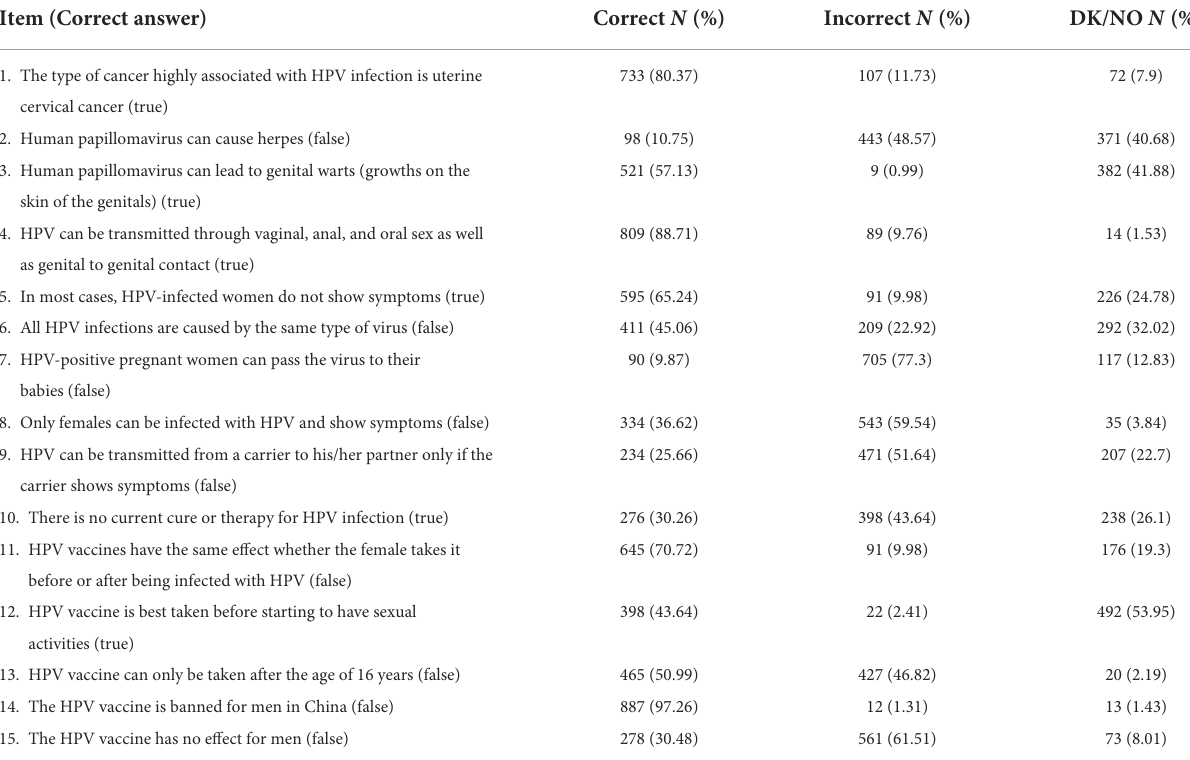
TABLE 2 Knowledge of HPV infection and